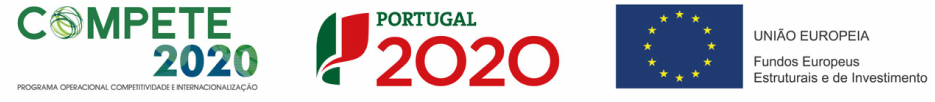
pomace; Table S2. HPLC − DAD /ESI-MS profile of nonanthocyanic compounds (low molecular weight phenolic compounds, flavan-3-ols and flavonols) detected in free polyphenol fractions ob- tained from grape pomace (CFP and FP-95); Figure S2. HPLC − DAD /ESI-MS chromatogram of